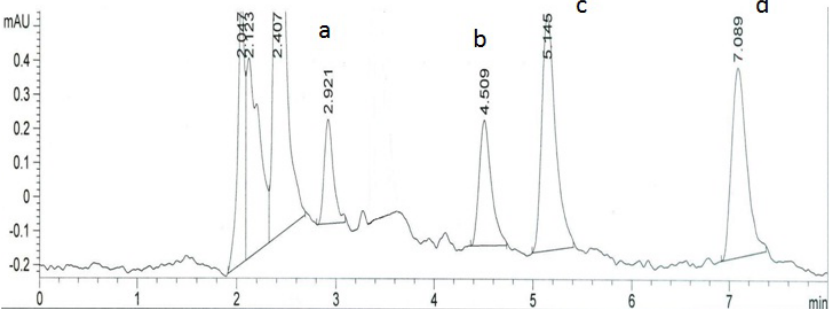
Figure 6. LC-PDA chromatogram of para- hydroxyatorvastatin ( a ), ortho- hydroxyatorvastatin ( b ), atorvastatin ( c ) and atorvastatin lactone ( d ) in